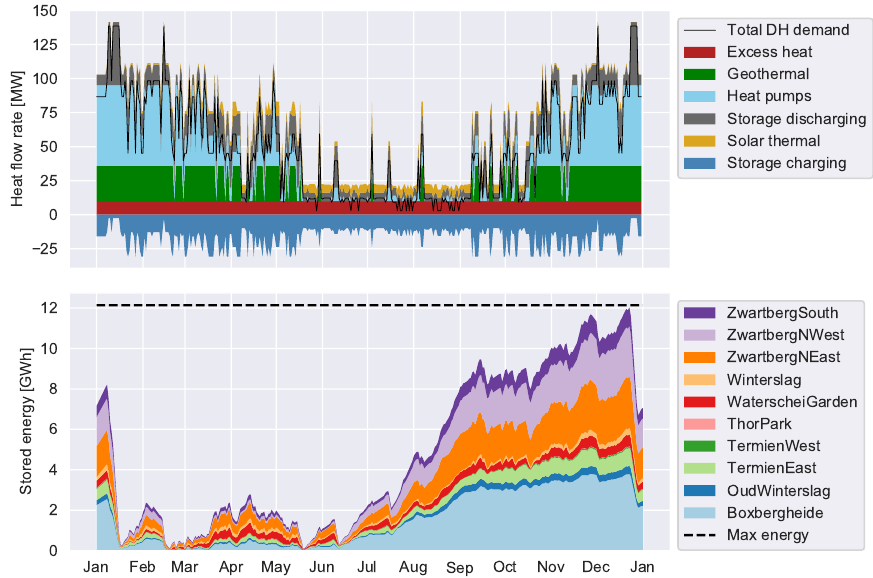
Figure 13. Full year time series for maximum PEIS